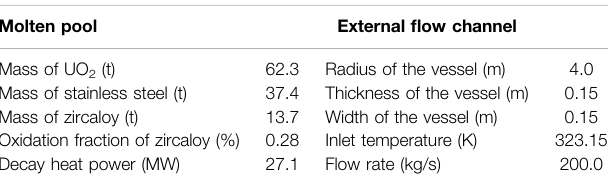
TABLE 1 | Main input parameters in AP1000 veri fi cation calculation. Molten